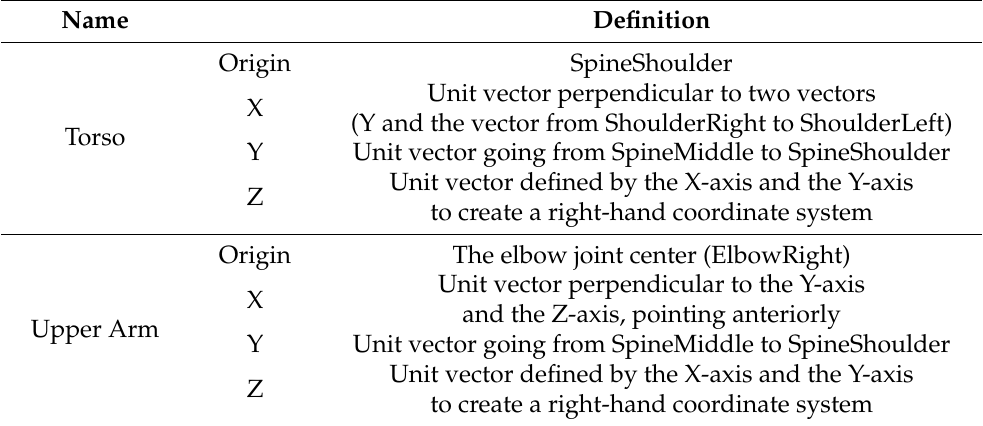
Figure 3. Kinect skeleton joints ( left ) and UWA marker set ( right ). Local segment coordination (LSC) systems of the torso and upper arm (taking the right arm as an example) are defined in Table 1. The kinematic model of Kinect Φ calculates three Euler angles for shoulder joint following the flexion (+)/extension ( − ) adduction (+)/ab- duction ( − ) and internal (+)/external ( − ) rotation order. The shoulder angles are denoted as α FE , α AA , and α IE . The elbow flexion angle, denoted as α EFE , is calculated using the trigonometric function by the position coordinates from ShoulderRight, ElbowRight, and WristRight. The model Φ is developed using Matlab 2018a. Table 1. Definition of the upper arm and torso anatomical segment coordinate system for the Kinect